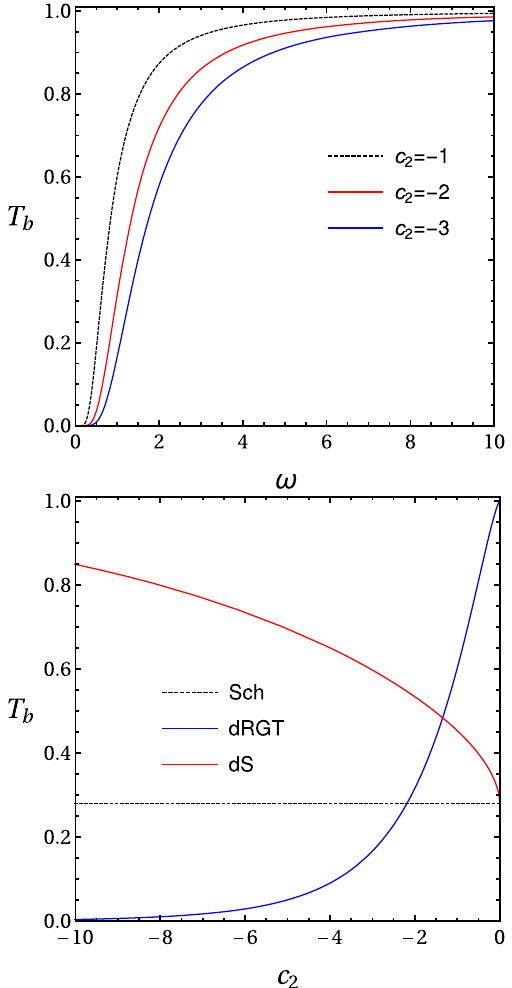
Fig. 8 The left panel shows the effect of parameter c 2 on the rigorous boundonthegreybodyfactorforadRGTblackholewith (cid:18) =0, ˜ M = α g = 0.1, and β m = 0.565375. The right panel shows a comparison of the rigorous bound on the greybody factor for a dRGT black hole with ˜ M = α = 0 . 1 ,ω = 1, and β g m = 0.565375